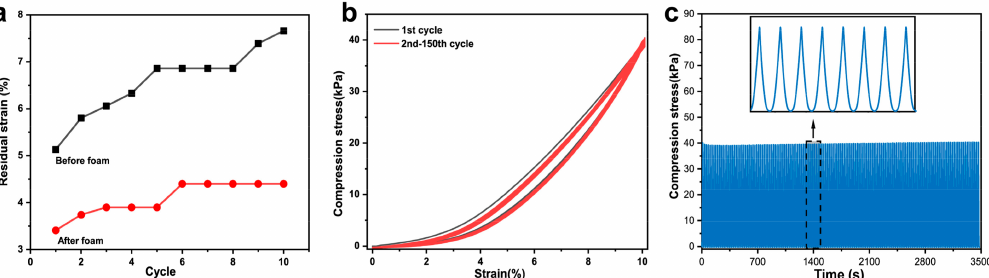
Figure 5. ( a ) A comparison of residual stress before and after foaming of TPU/4MWCNTs at 40% compression strain; ( b ) stability of TPU/4MWCNTs composite foam at 150 cycles of 40% compres- sion; and ( c ) maximum stress maintained in TPU/4MWCNTs composite foam at 150 cycles of 10% strain